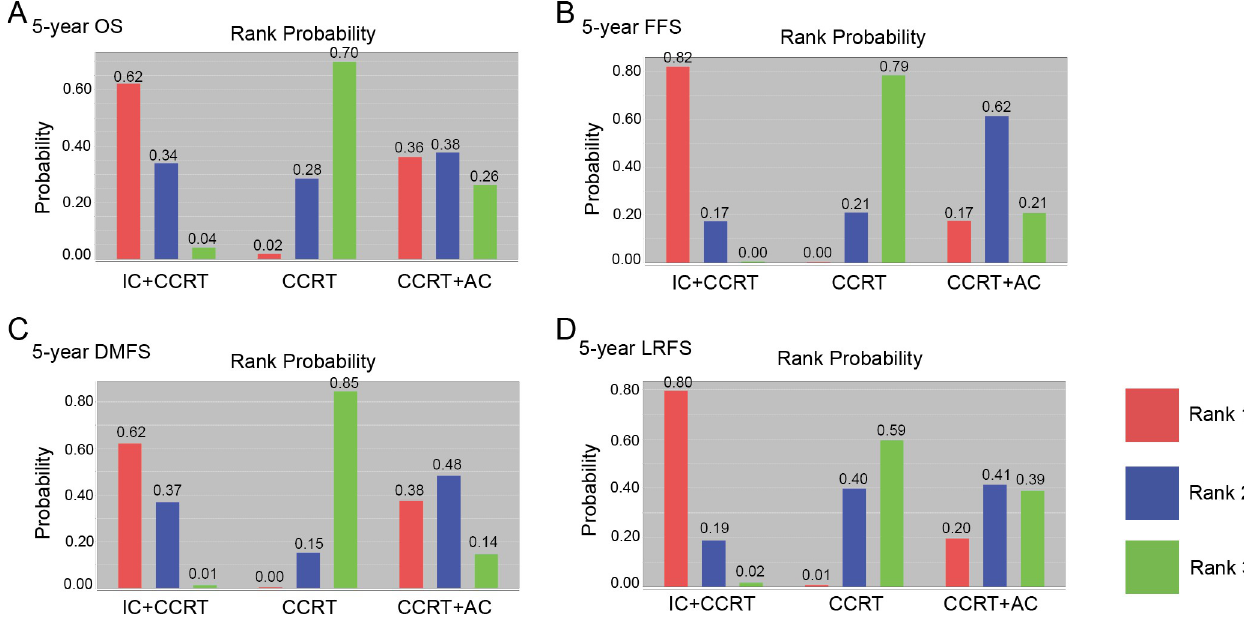
Fig 3. Rank probabilities of each treatment based on the random-effects model. (A) 5-year overall survival; (B) 5-year failure-free survival; (C) 5-year distant metastasis-free survival; (D) 5-year locoregional recurrence-free survival.